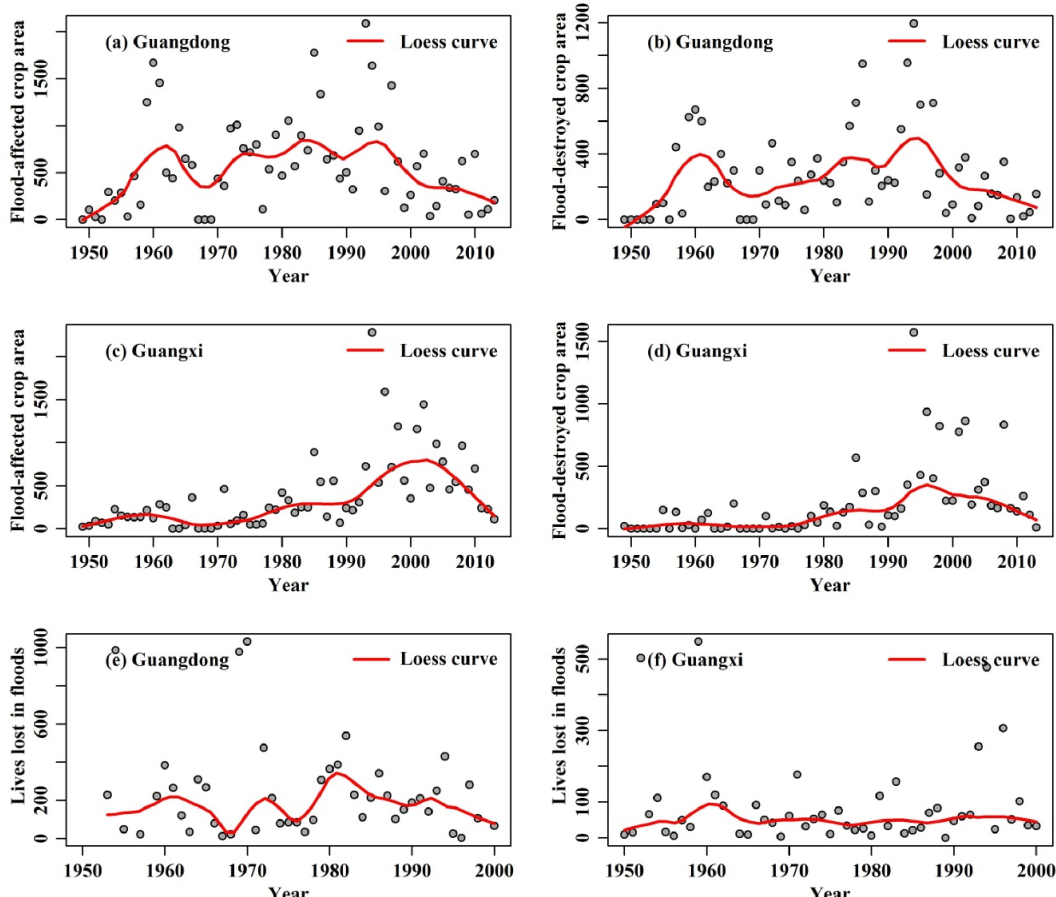
Figure 11. Temporal changes of flood-hazard-induced crop areas and mortality in Guangdong and Guangxi